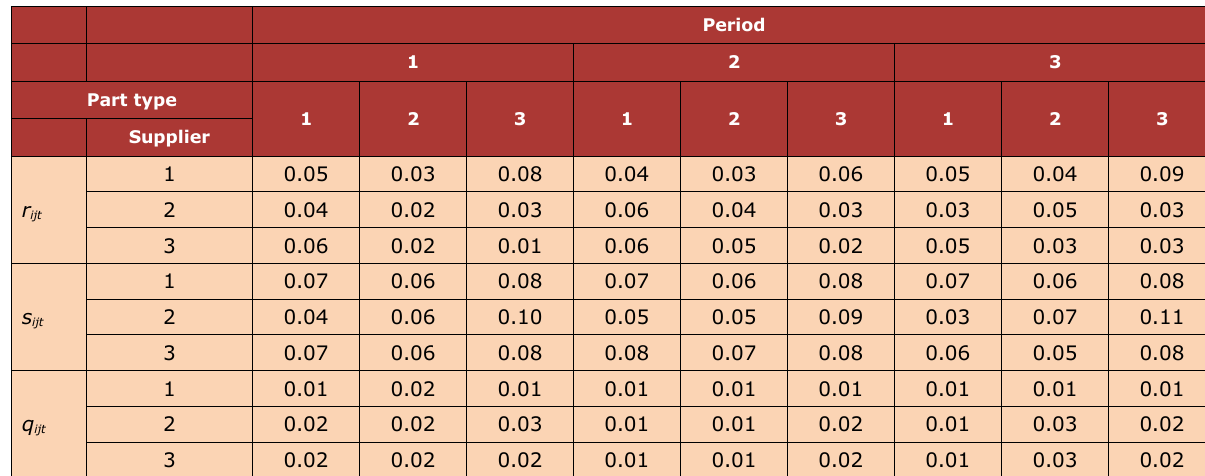
Table 6. Values of expected defect rate, disruption rate and delay rate of supplier i for part type j in period